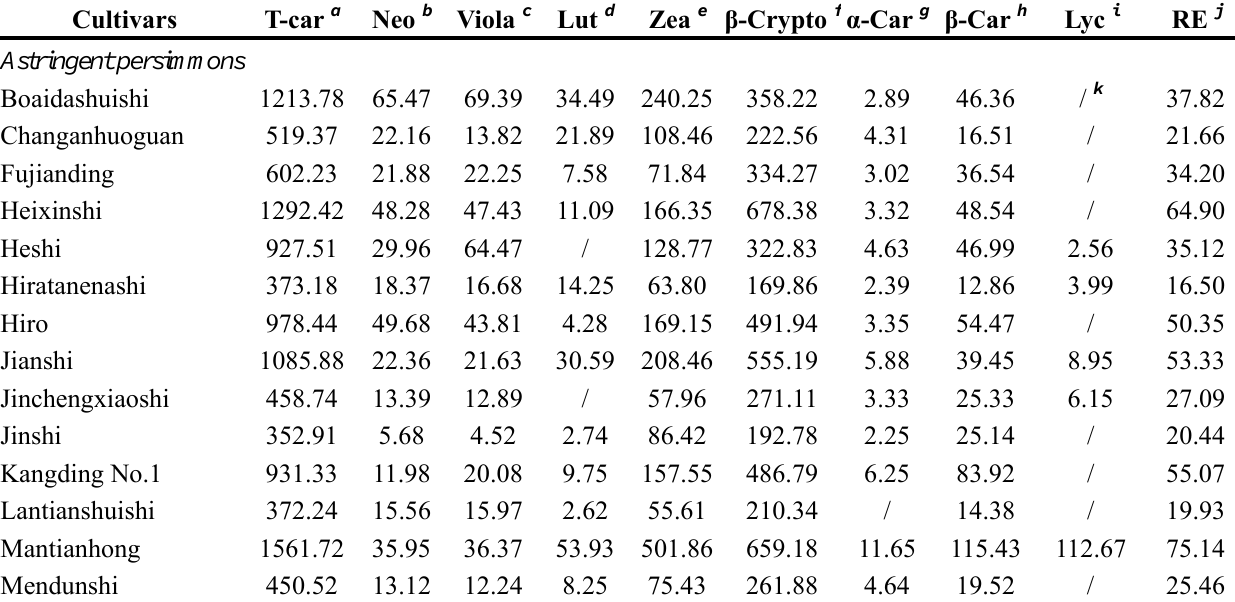
Table 3. The contents of carotenoids in the fleshes of different persimmon cutivars ( μ g/100 g FW).